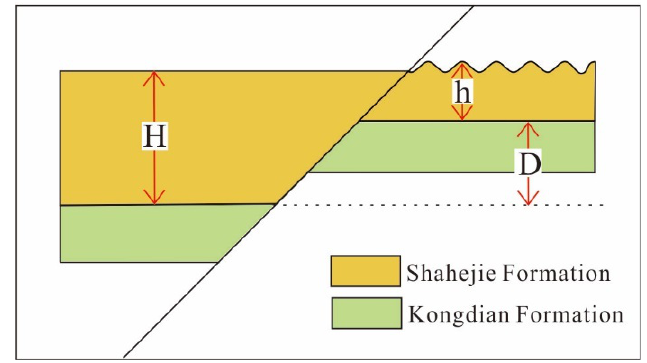
Figure 4. The calculation principle of fault throw in the study